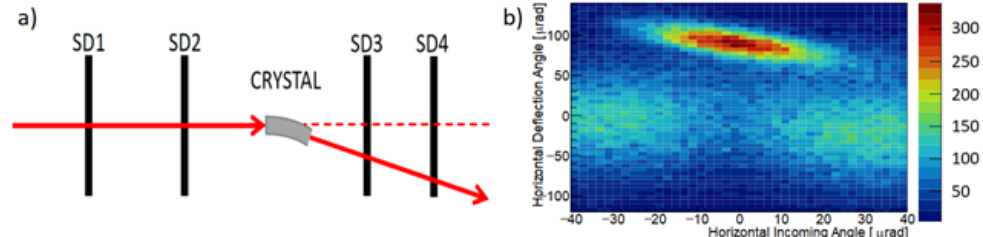
Figure 18. ( a ) Scheme of a tracking system to study channeling beam deflection. ( b ) By tracking each particle trajectory before and after the crystal, is possible to study channeling in great detail, such as study deflection in function of the incoming particle